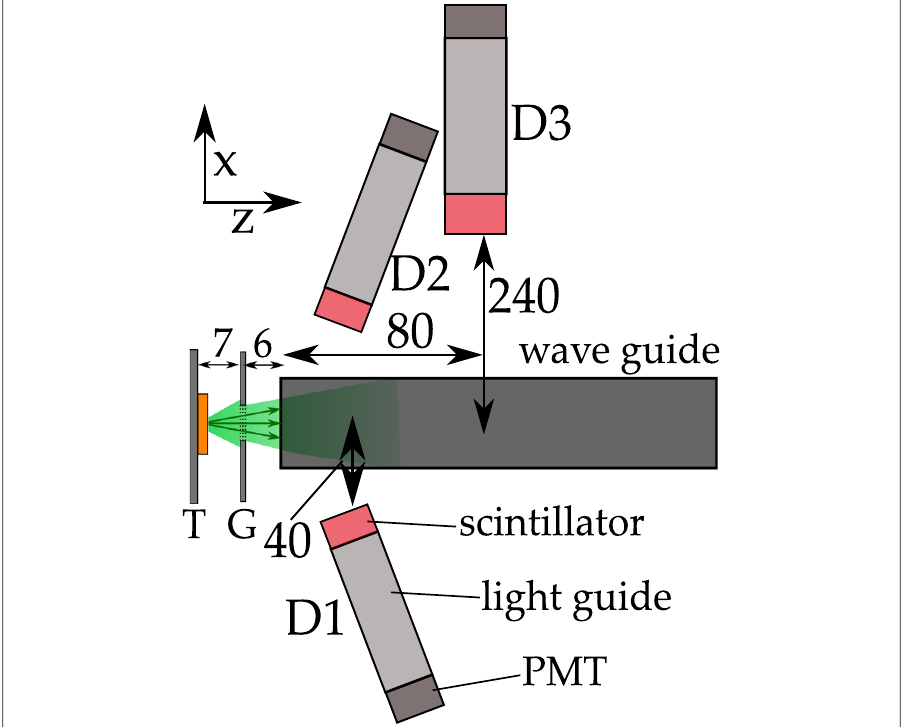
Fig. 2 Schematic positions of the three γ -ray detectors relative to the waveguide structure (not to scale). D1 and D2 were symmetrically placed near the Ps production region, and D3 was located further away, with a field of view covering the entire waveguide region. All dimensions are in